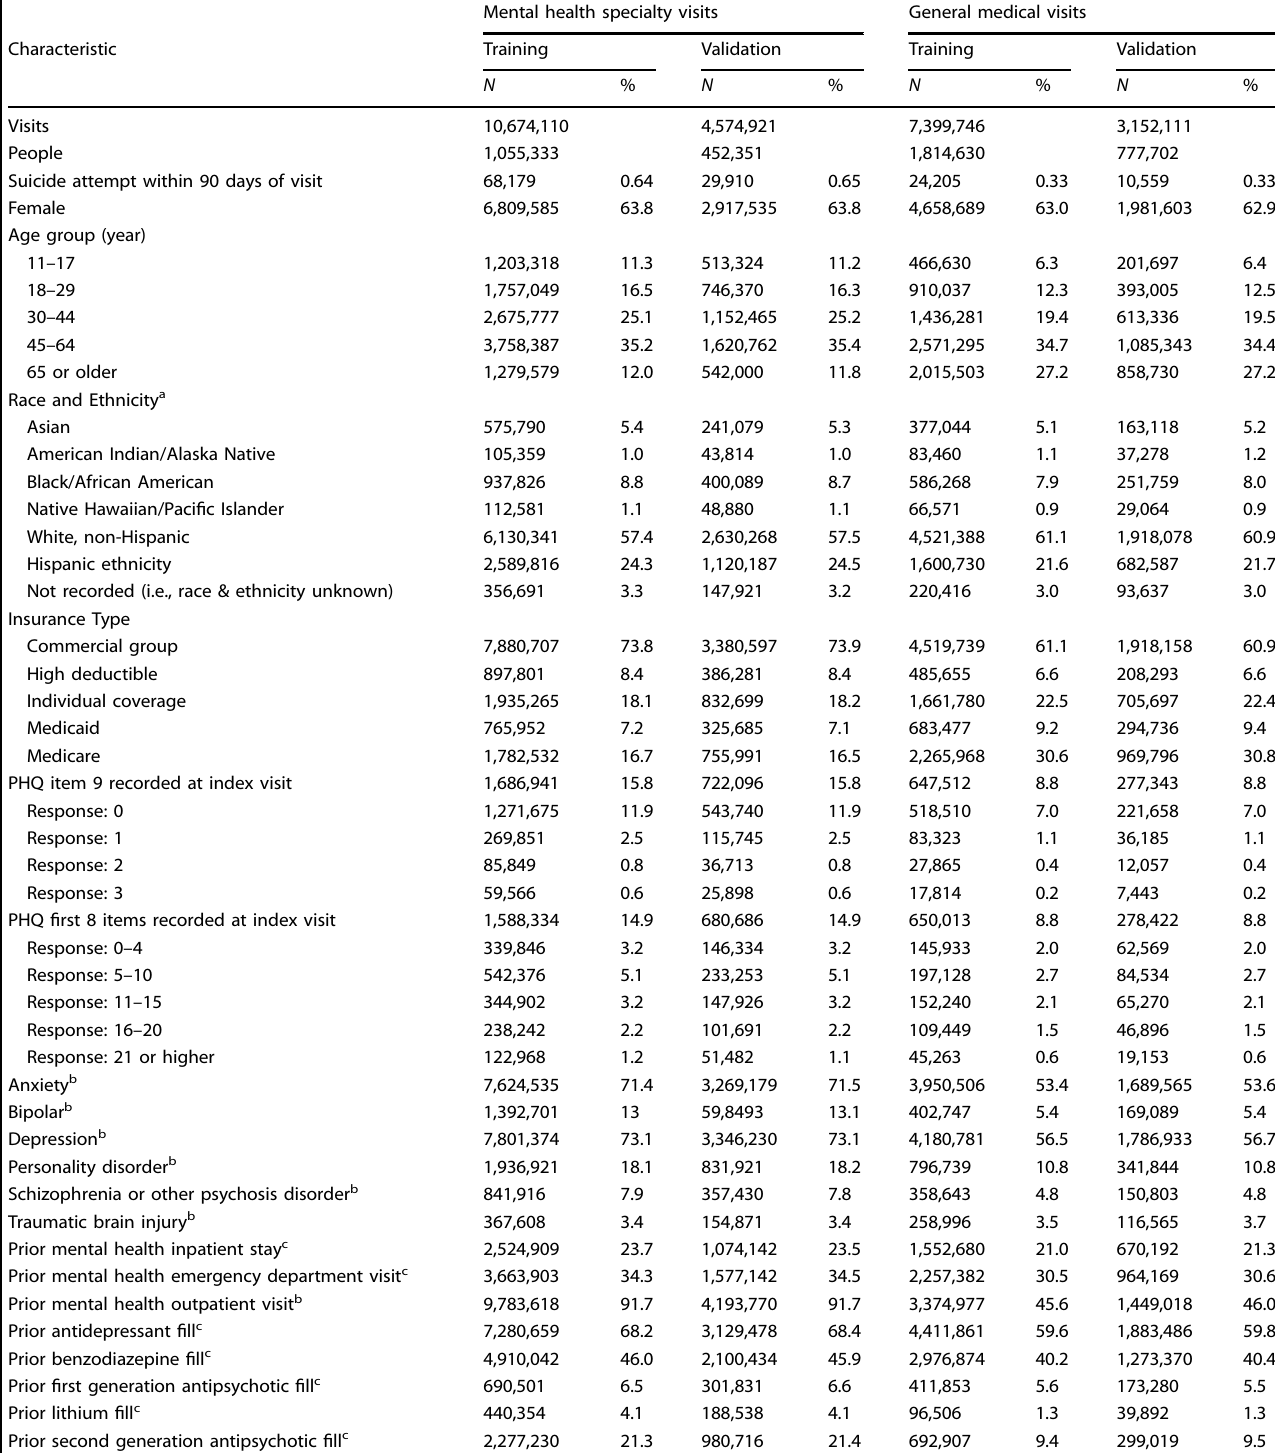
Table 1. Cohort description of training and validation sample for mental health specialty visits and general medical visits used to estimate suicide attempt (fatal and nonfatal) risk prediction model. Mental health specialty visits General medical visits Training Validation